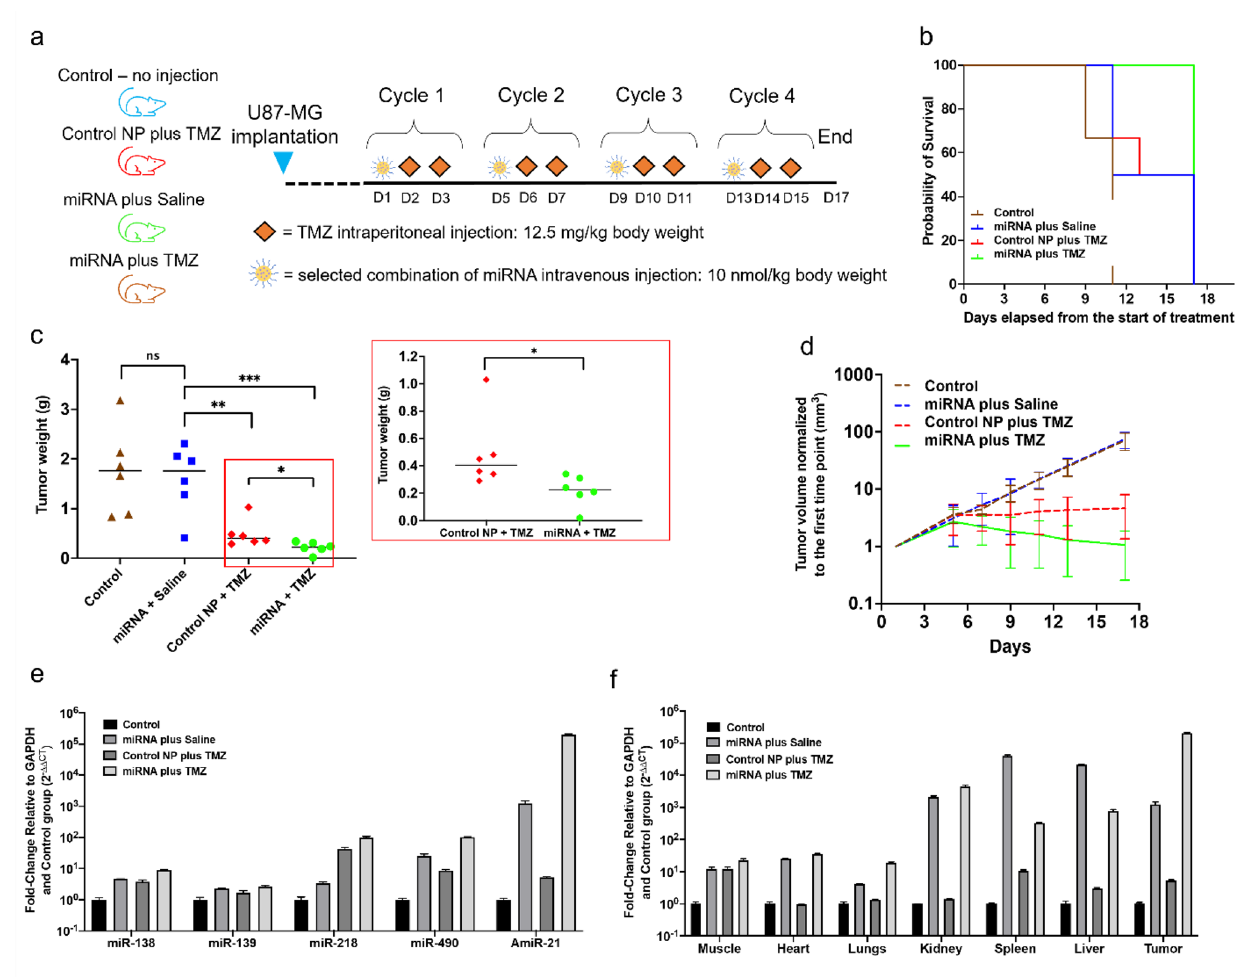
Figure 6. In vivo evaluation of the delivery and chemosensitizing effect of the panel of miRNAs (miR-138, miR-139, miR-218, miR-490, and Amir-21) followed by TMZ in U87-MG xenografts in mice. ( a ) Schematic of in vivo workflow. ( b ) Survival curves of the mice at different treatment group (number of tumors, N = 6–8 per group). ( c ) Tumor weight at the terminal point for mice in different treatment groups. The insert shows the last two groups. ( d ) Estimated tumor volume in different treatment groups. Since some of the mice were sacrificed earlier, all the curves except miRNA plus TMZ were estimated by fitting an exponential growth model to data. ( e ) Biodistribution of miRNA-138, miRNA-139, miRNA-218, miRNA-490, and antimiRNA-21 in tumors of mice in different treatment groups. ( f ) Biodistribution of antimiRNA-21 in different organs of mice in different treatment